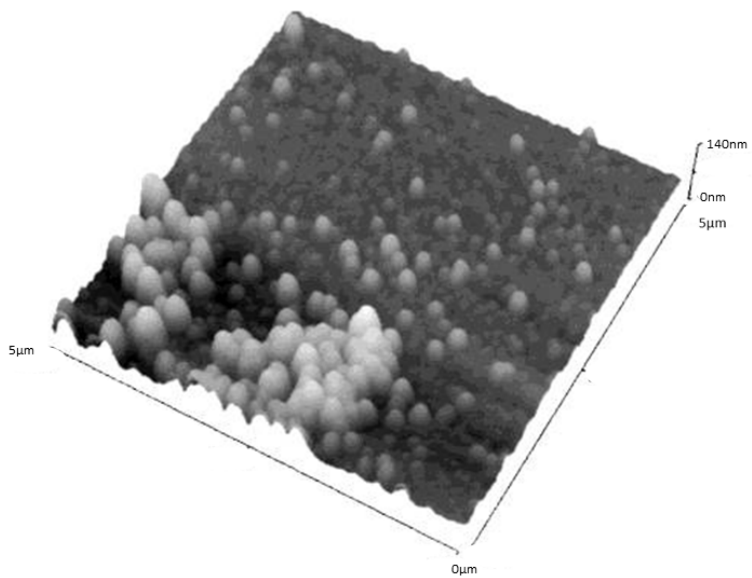
Figure 19. Non-contact mode AFM image of the solid lipid nanoparticles formed by 15 on mica at 5 × 5 μ m scan size, z axis is 140 nm. A 20 µL portion of a suspension of the SLNs was deposited, and imaging was performed after drying for 24 h at 25 °C